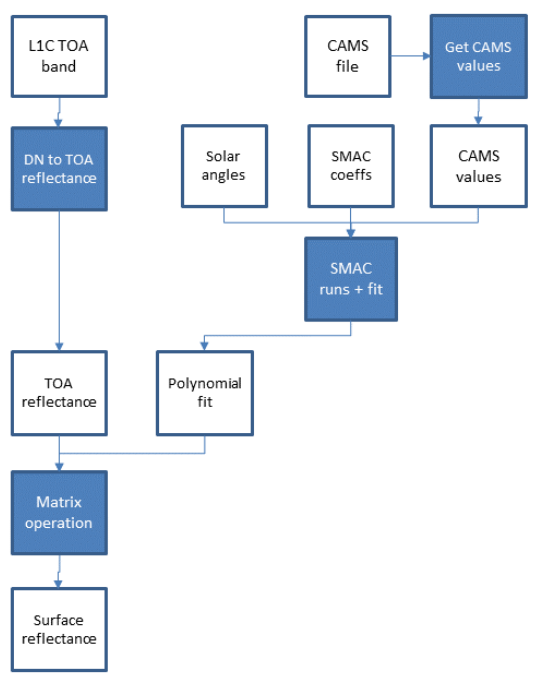
Figure 3. Sen2Like Fast Atmospheric Processing Workflow diagram by using SMAC LUT.